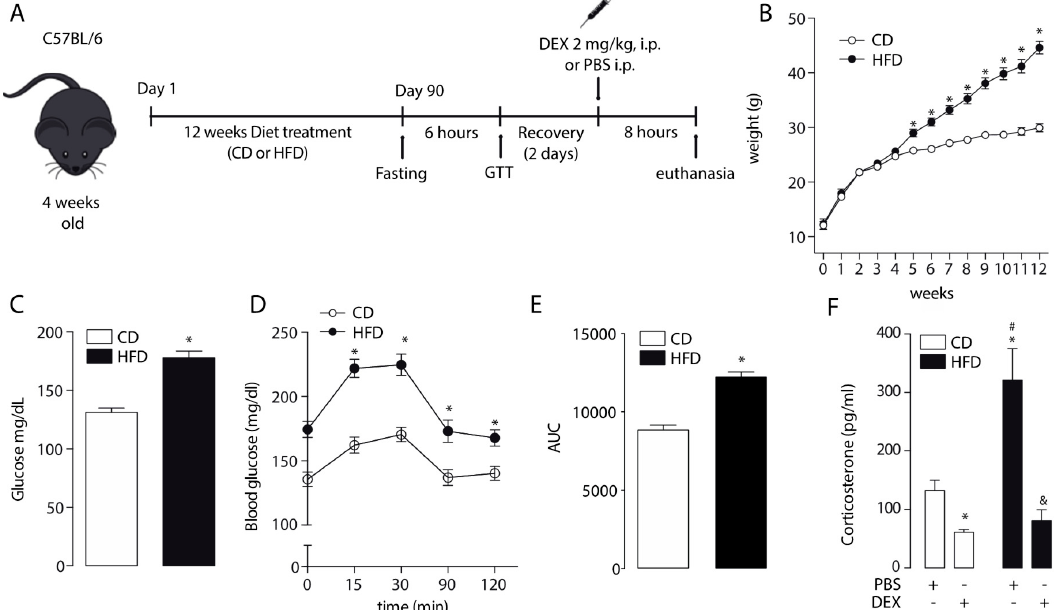
Figure 1. Effect of a high-fat diet on body weight, glucose homeostasis, and corticosterone plasma levels. ( A ) Study design. ( B ) Body weight. ( C ) Fasting glucose. ( D ) Glucose tolerance test (GTT). ( E ) GTT area under the curve (AUC). * p < 0.05, unpaired t -test. ( F ) Corticosterone plasma levels after a